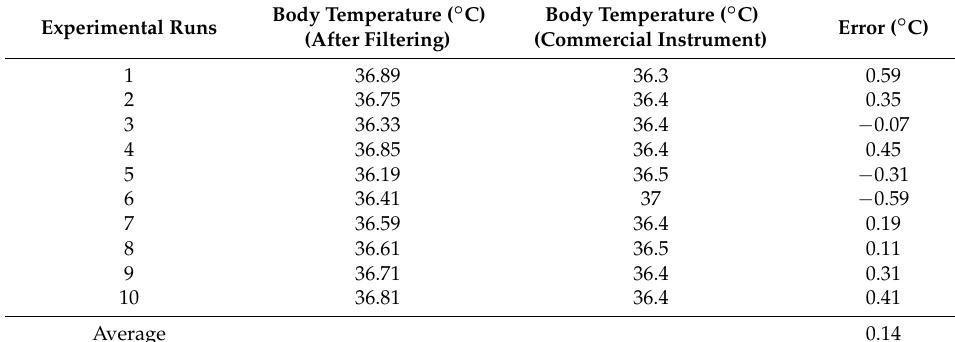
Table 7. Difference between the body temperature measured in this experiment and that measured using a commercially available infrared temperature gun.